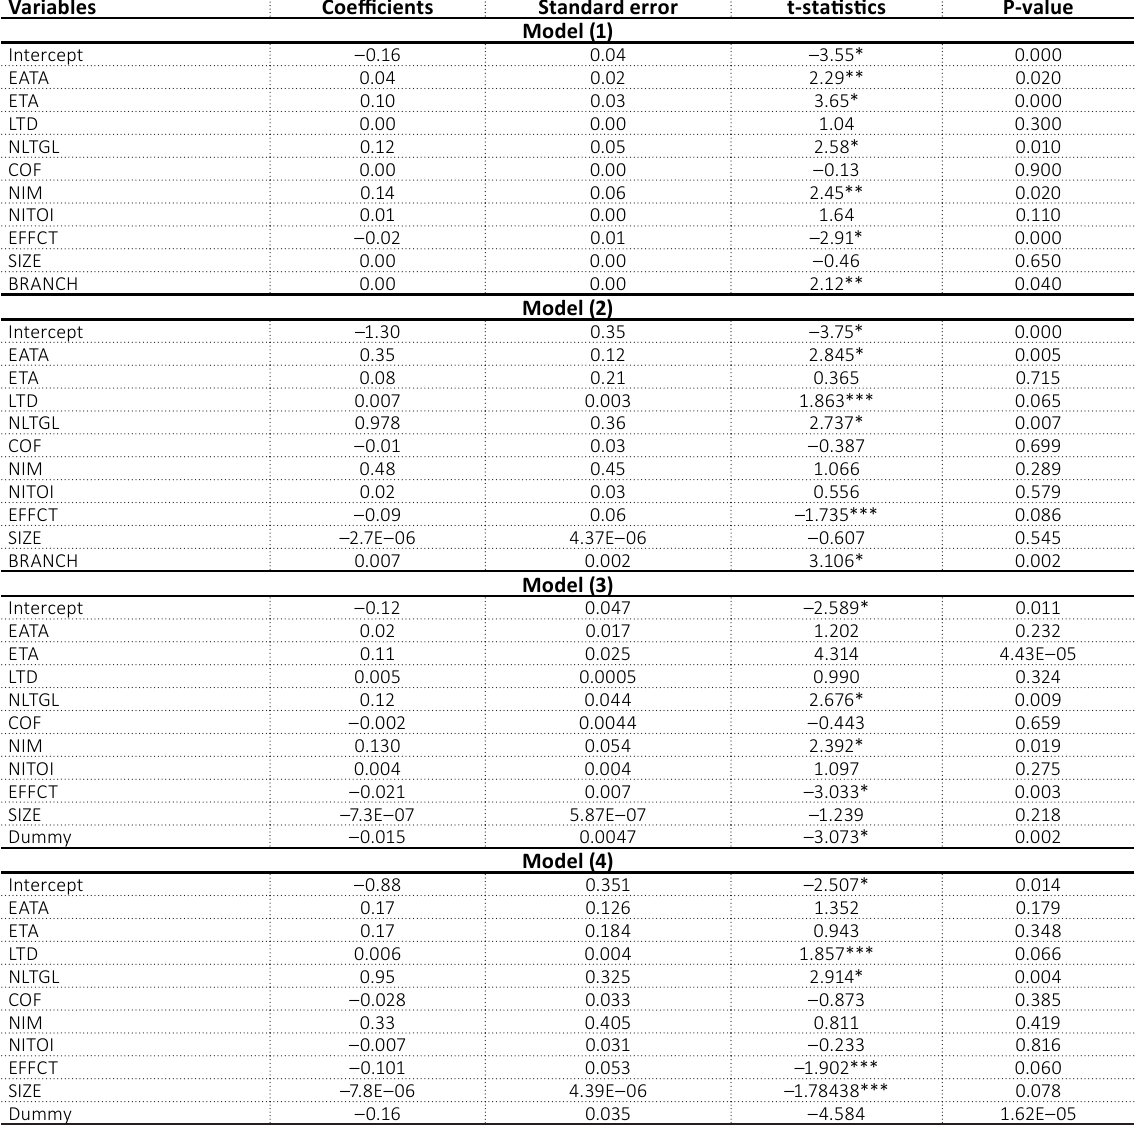
Table 5. Test statistics of regression coefficients – Models (1), (2), (3) and (4)